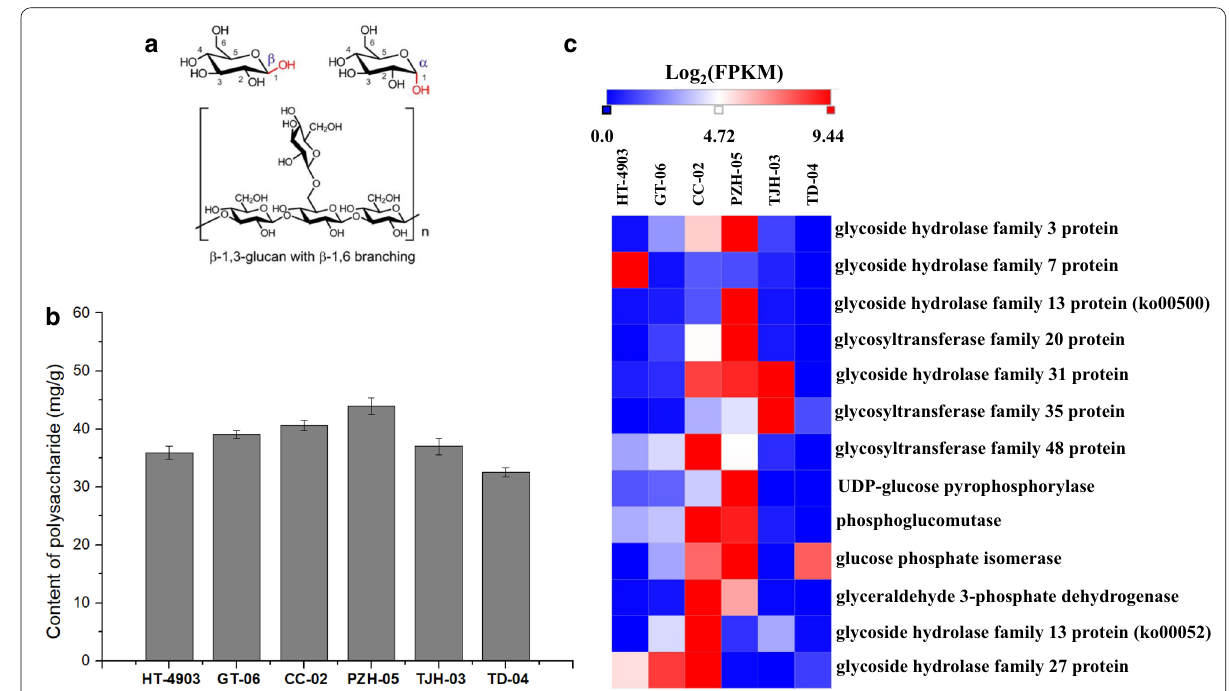
Fig. 4 The basic structure of typical mushroom polysaccharides ( a ), polysaccharide content ( b ) and the expression of important genes for polysaccharide biosynthesis ( c ). Mean polysaccharide contents are shown with standard errors bars from three repeated